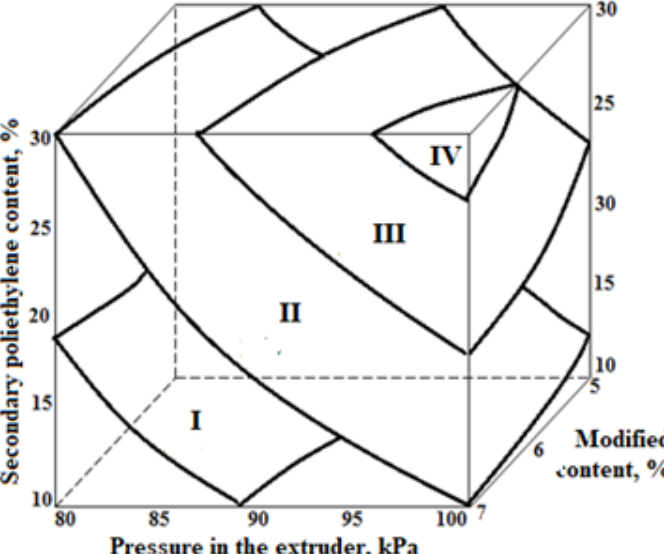
Figure 3. Dependence of the compressive strength of polyethylene foam boards at 10% defor- mation (Y2, kPa) on the consumption of recycled polyethylene and the modifier, as well as on the air pressure in the extruder at the optimum flame retardant consumption of 11.7 kg/m 3 . The value of compressive strength, kPa: I-100; II-120; III-140; IV-160.